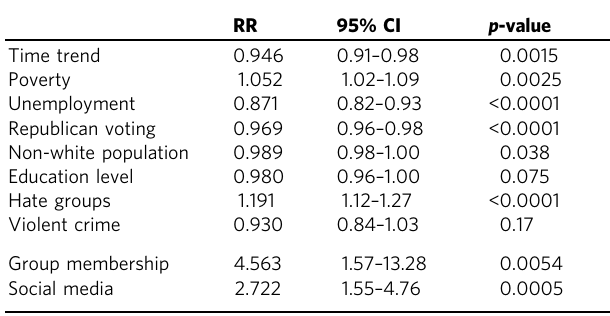
Fig. 2 The untied locations of far-right extremists exposed in the PIRUS database between 2005 and 2017. The color of each county corresponds to its log-transformed population density. Table 1 The results of the twinstim modeling, with estimated rate ratios (RR), Wald con fi dence intervals, and p